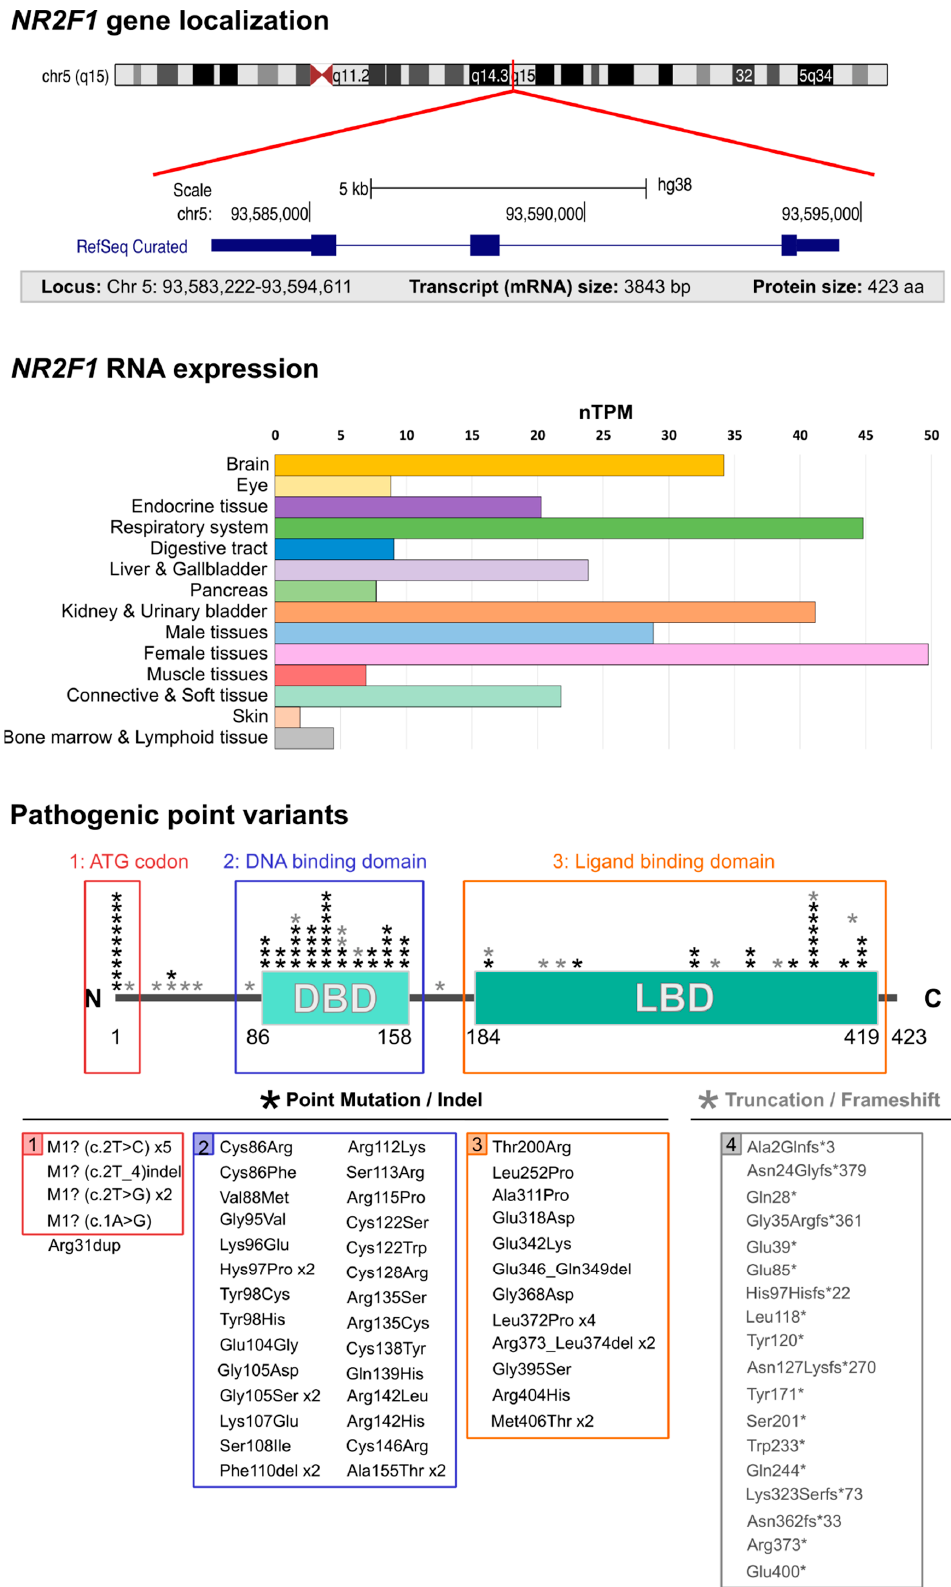
Figure 1. Schematic representations of NR2F1 gene localization, expression profile and pathogenic point variants. The human NR2F1 gene, located on chromosome 5 (region 5q14–q15), codes for a